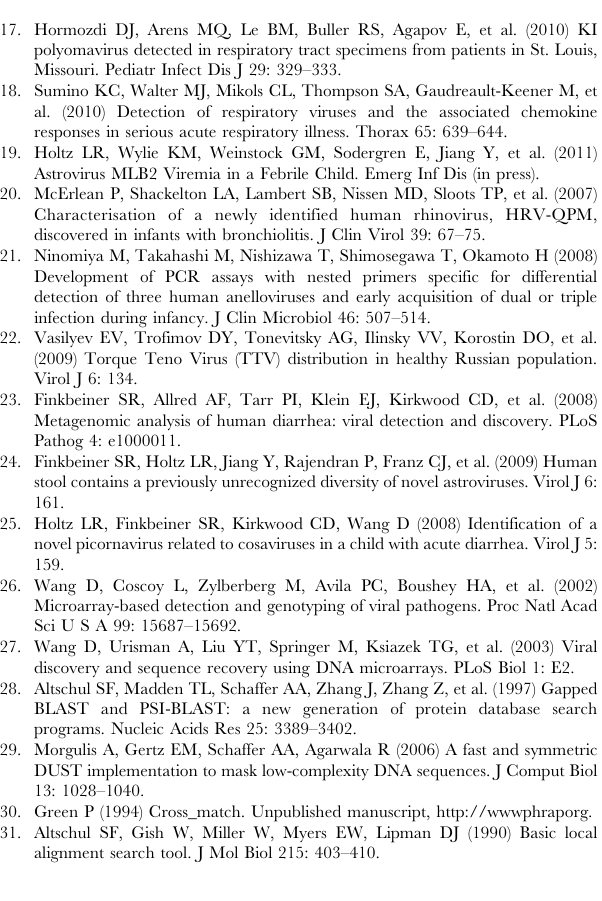
Figure S1 General statistics on the number of sequenc- es generated. The mean, minimum, maximum, and median numbers of reads for each group of subjects are presented in the table. The distributions of the number of sequences generated for each subject group are plotted below. (DOC) Figure S2 Lower Ct values (indicative of more virus) correlate with higher numbers of viral sequences. The average Ct value (red squares) and the number of sequence reads generated (blue bars) are graphed for samples that were positive by both real-time PCR and sequencing for (A) adenovirus, (B) enterovirus, and (C) bocavirus and parechovirus. (TIF) Figure S3 Samples with additional sequences generated to assess detection of rare sequences. (DOC) Figure S4 Accession numbers for sequence data sets.